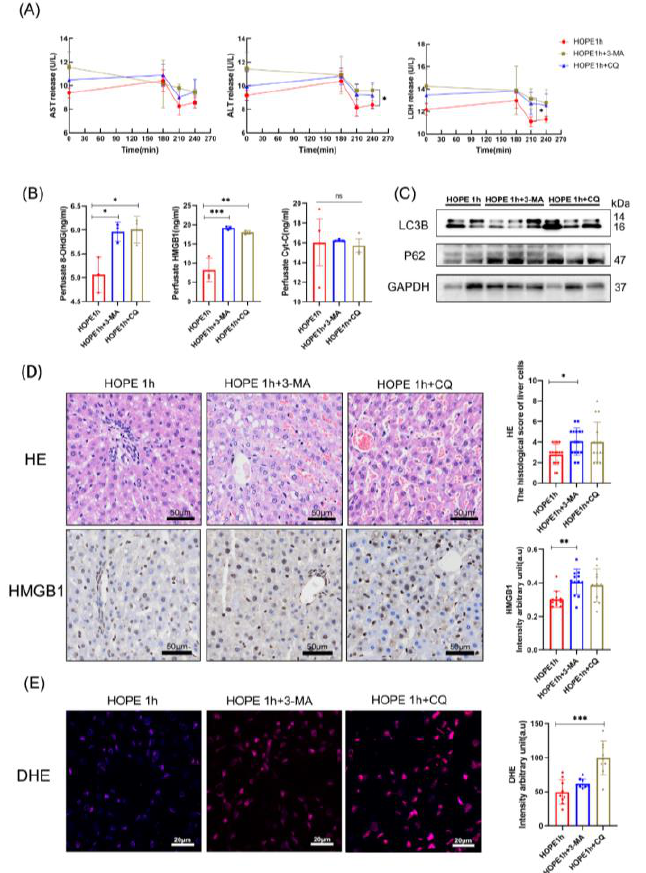
Figure 6. Autophagy inhibition attenuated the protective effect on DCD liver with HOPE 1 h. ( A ) The perfusate ALT, AST, and LDH data were transformed to a log2 scale. ( B ) 8-OHdG, HMGB1, and Cyt C in perfusate. ( C ) Western blot shows the autophagy-related protein levels. ( D ) H&E staining, scale bar : 50 μm; IHC staining of HMGB1, scale bar: 50 μm ; histological scores were analyzed based on Suzuki’s criteria, and IHC-stained cells was quantified using Image J. ( E ) DHE staining was quantified using Image J, scale bar: 20 μm. ( n = 3 independent experiments). Mean ± SD, N.S., p > 0.05, * p < 0.05, ** p < 0.01, *** p < 0.001.